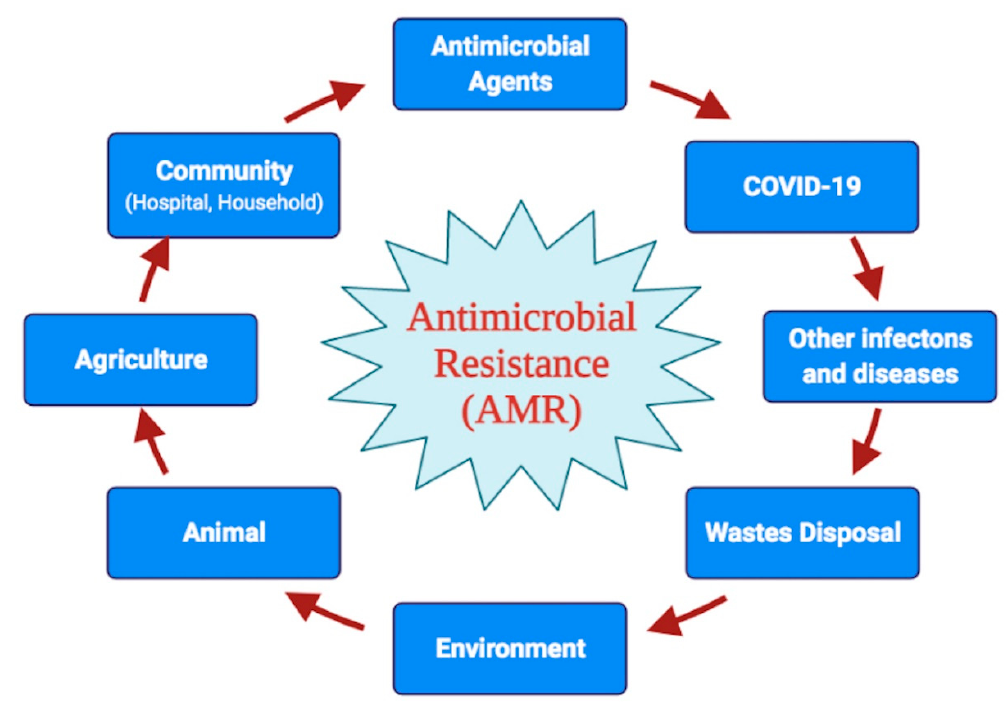
Figure 1. Schematic representation of various factors, causes and consequences contributing towards the emergence and spread of antimicrobial resistance.